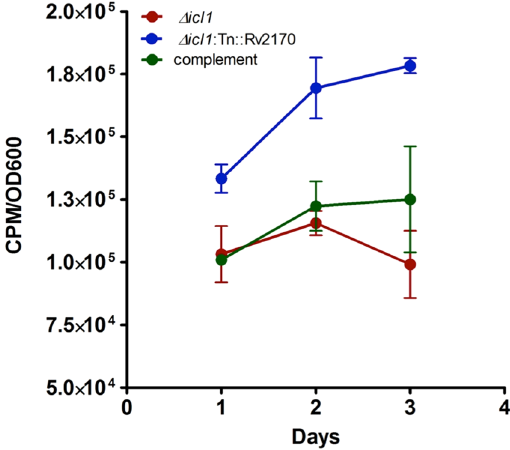
Figure 2. Inactivation of Rv2170 in the Δ icl1 mutant increases generation of CO 2 from stearic acid. Metabolic activity of the bacterial cell was determined using conversion of stearic acid to CO 2 . Mtb strains were grown in minimal medium containing [1- 14 C] stearic acid and cold 0.05 mM stearic acid: Δ icl1 strain, Δ icl1:Tn::Rv2170 and complementation strain. CO 2 released from culture was trapped with NaOH and the labeled CO 2 was analyzed with a scintillation counter. The CPM data are shown at different time points. Data are representative from biological